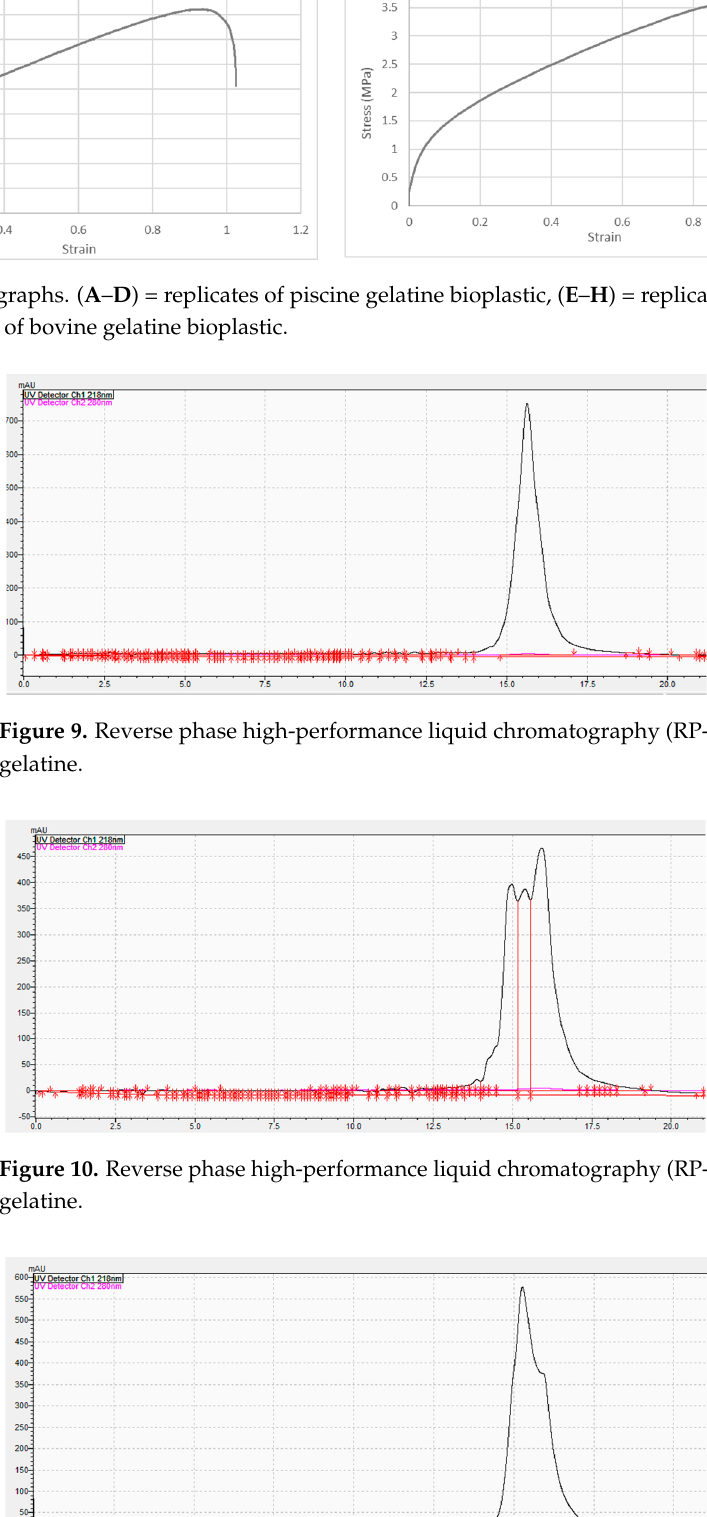
Figure 8. Stress over strain graphs. ( A – D ) = replicates of piscine gelatine bioplastic, ( E – H ) = replicates of porcine gelatine bioplastic, ( I – L ) = replicates of bovine gelatine bioplastic.